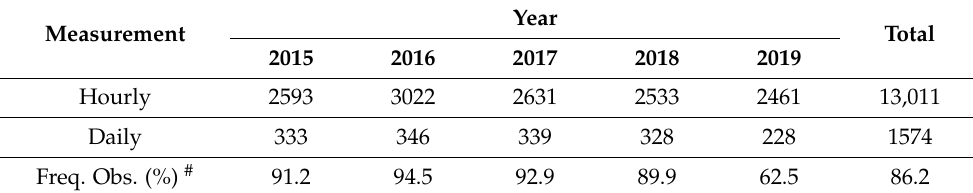
Table 1. Dataset